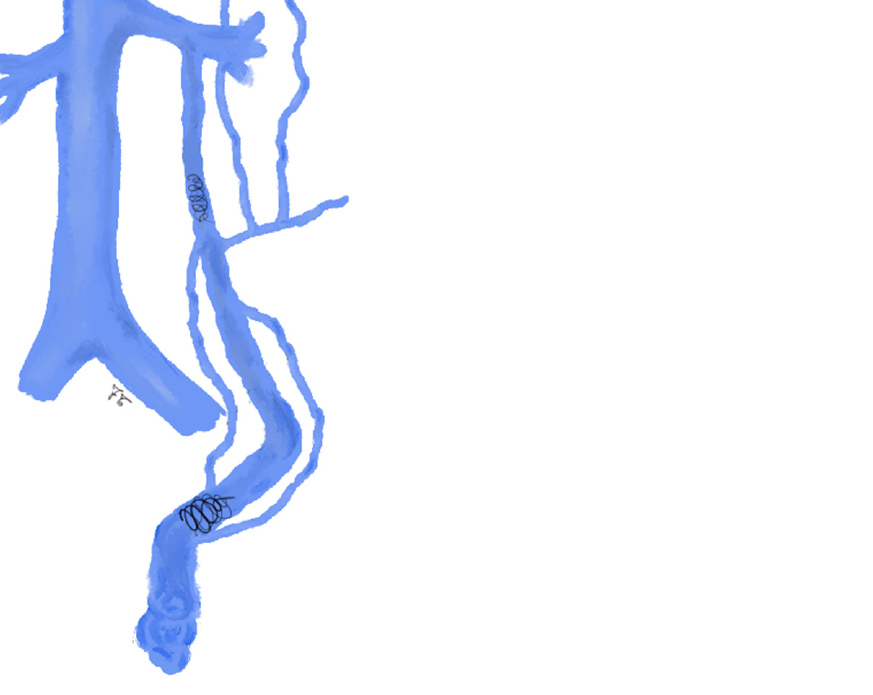
Figure 1. Drawing shows spermatic vein embolization with coils: coils are first deployed as distal as possible and up to the inguinal canal. Then, a sandwich occlusion of the spermatic vein is performed with additional coils in the proximal part of the spermatic vein.